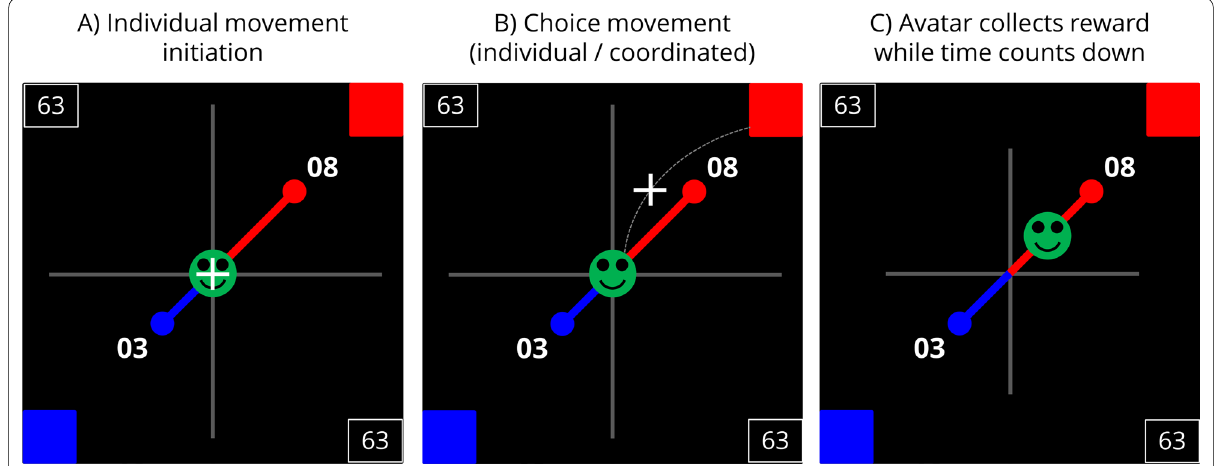
Fig. 3 Sketch of the experimental screen and procedure. ( A ) Each trial started with the presentation of the avatar and the two decision options. The cursor was locked in the centre of the screen. The current score that the participants had already collected was shown in the top/left and the bottom/right corner of the playing area. ( B ) To select an option, participants navigated the cursor into the colour-coded response box in the upper right/ lower left corner of the playing area. ( C ) After reaching a target box, the avatar started to move along a conjunction line from the centre of the screen to the place where the chosen option was presented. While the avatar was moving, a limited amount of time was counted down (demonstrated by reducing the length of the grey crossed lines in the background). Due to the greater distance to the avatar, more time was required to collect the later/larger